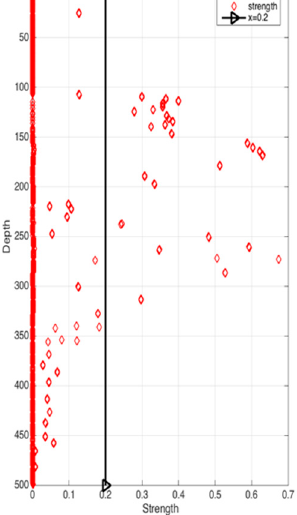
Figure 10. Correlation between depth and strength.